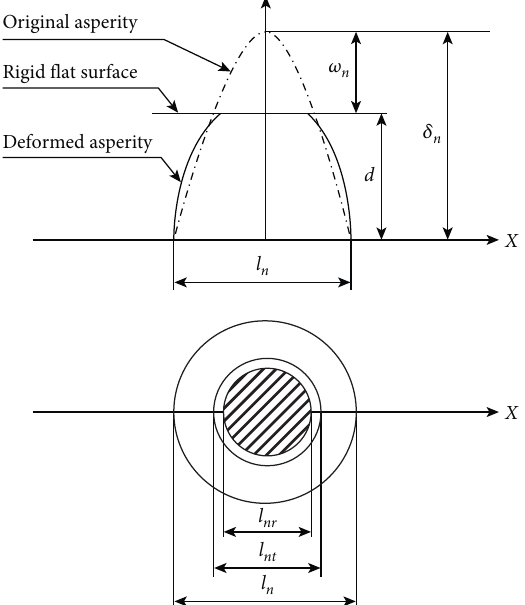
Figure 2: The contact between a fractal asperity at level n and a rigid smooth plane, where l n , l nr , and l nt are the base diameter, the real contact diameter, and the truncation diameter, respectively